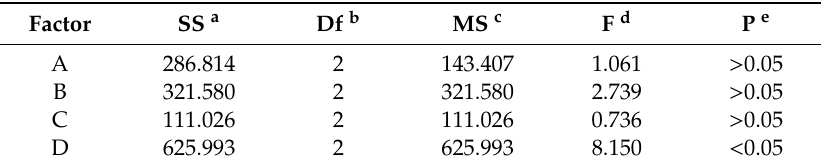
Table 3. Results of variance